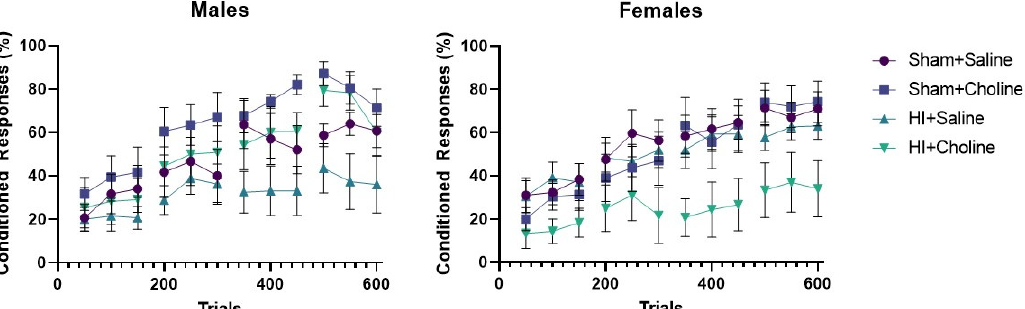
Figure 5. Choline improved cerebellar-dependent learning in males subjected to hypoxia ischemia but not females. Male and female rats were tested in a trace eyeblink Pavlovian conditioning task in young adulthood. Data are presented in 50-trial blocks. Rats were presented with 150 training trials per day. Left Panel: Choline administration improved performance of male rats regardless of the surgery condition, p < 0.02. HI males treated with saline exhibited poor learning across days, and this was significant for the last two days of training, p < 0.03. Right Panel: Choline treated females performed poorly across all four training days. Analysis of the last two training days indicated a significant surgery × treatment interaction, because only HI females treated with choline performed poorly, p < 0.04. Choline did not affect behavior in sham control females and HI females treated with saline outperformed females treated with choline. Sham control groups consisted of 6–7 rats each; HI groups consisted of 7–9 rats each. HI = hypoxia ischemia.